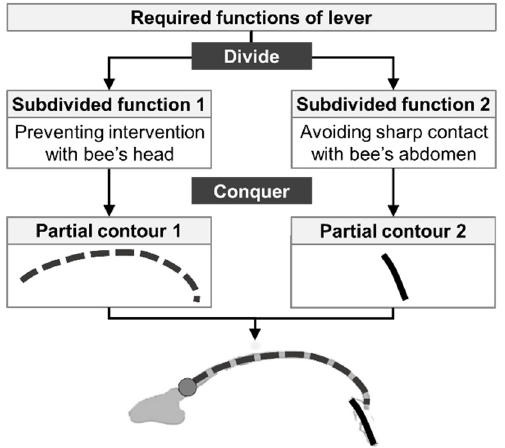
Figure 2. Morphological principle of the staminal curved lever of Salvia pratensis flower. The lever’s required functions are subdivided into functions (divide) and assigned to each partial contour as design goals. Each partial contour has a proper shape only to satisfy their subdivided function (conquer). The combination of each partial contour forms the final contour of the curved lever.